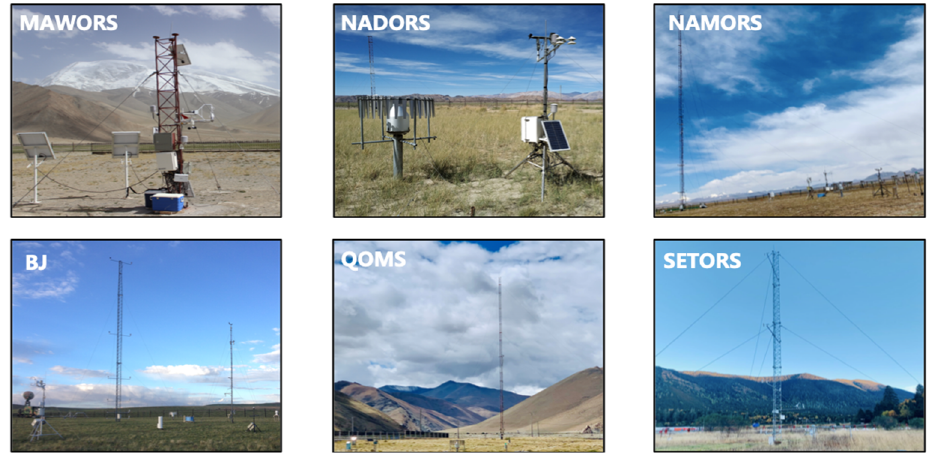
Figure 1. Instrument setup and subsurface conditions at the observation site [16].